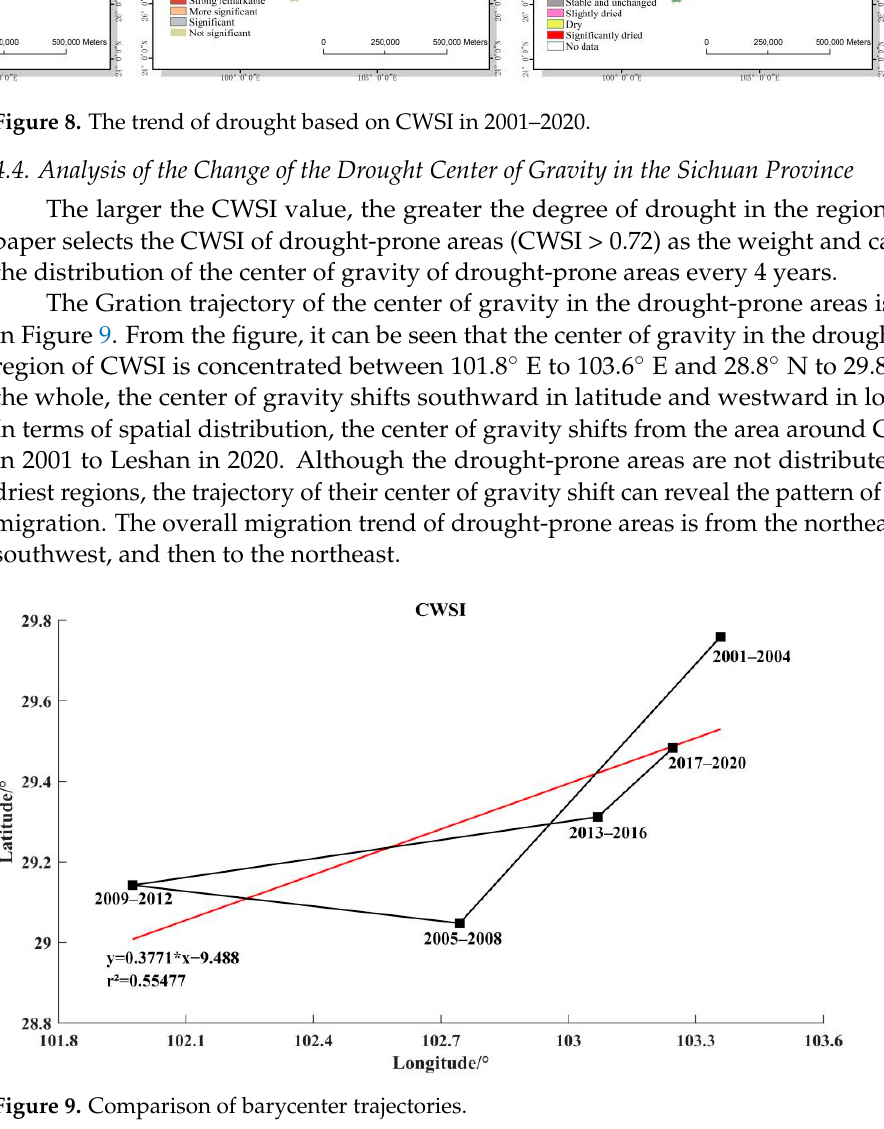
Figure 8. The trend of drought based on CWSI in 2001–2020. Table 2. Category of significant variation of drought trend.